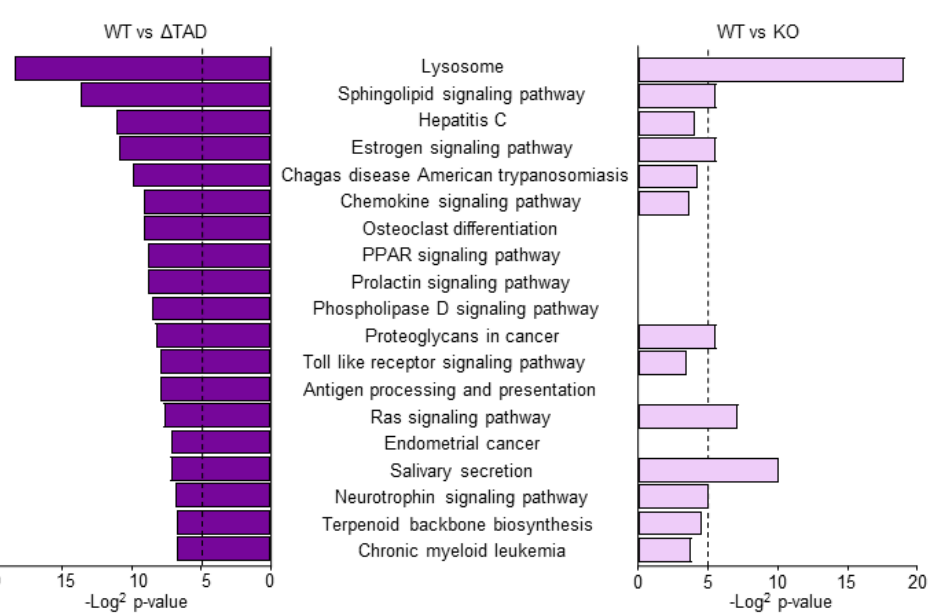
Figure 5. Functional enrichment analysis of differentially expressed genes. Significance ( p-values ) for KEGG pathways enriched in differentially expressed genes between wild-type and Δ TAD macrophages in wild-type vs. Δ TAD ( left ) and wild-type vs. knock-out ( right ) macrophages. The dotted lines indicate p = 0.05 .